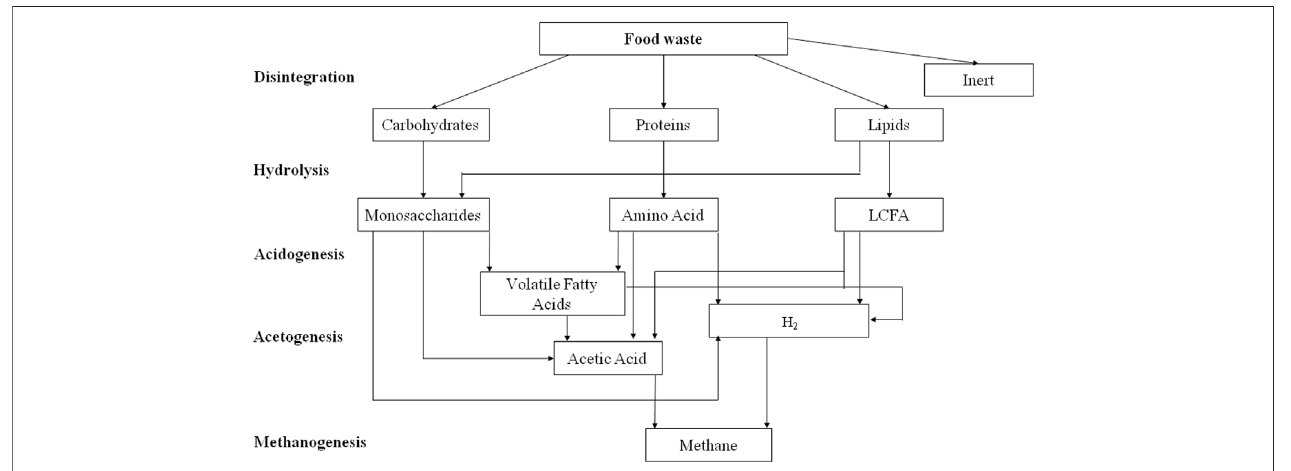
FIGURE 2 | Step-wise detailed bioprocess mechanism in anaerobic digestion vis-à-vis the biological products generated.